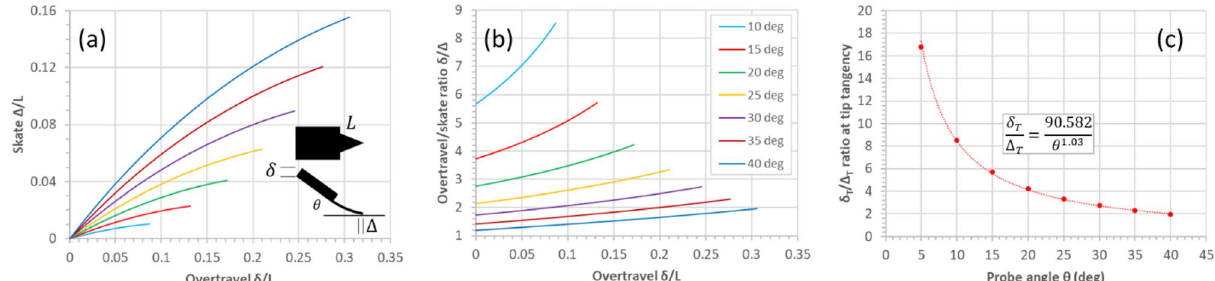
Figure 14. Universal skate/overtravel curves for tilted triangular cantilevers bending in contact with a surface due to an imposed overtravel. ( a ) The skate versus the overtravel as a function of cantilever tilt angle. ( b ) The overtravel/skate ratio as a function of cantilever tilt angle. ( c ) The tangency overtravel/stake ratio versus the cantilever tilt